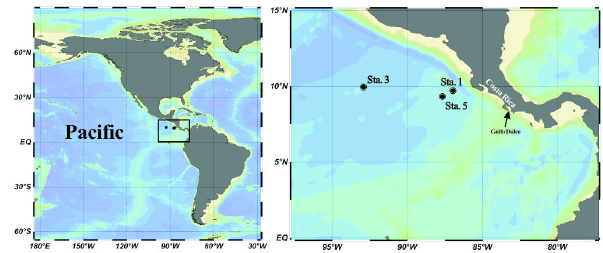
Figure 1. Location of sampling stations in Costa Rica Dome